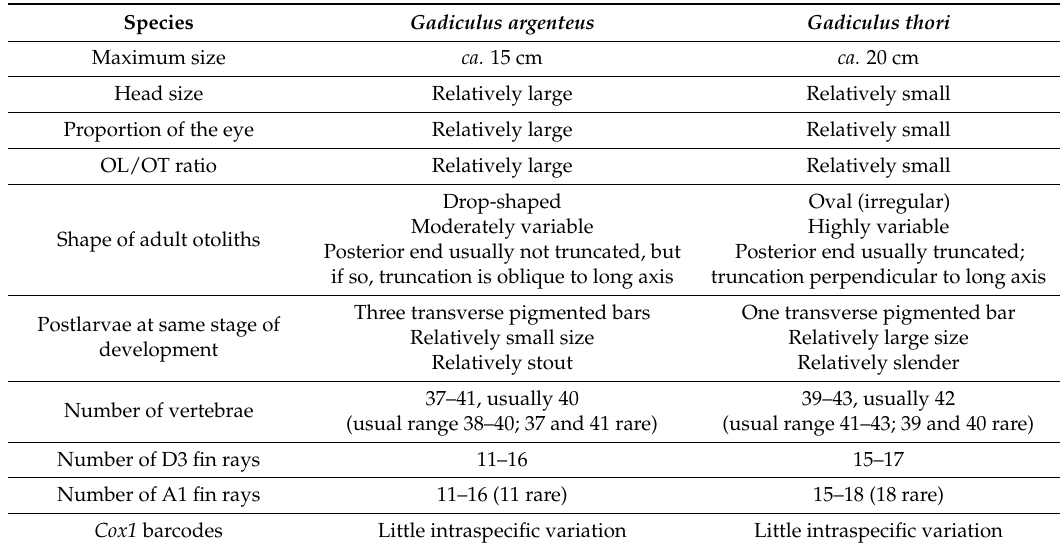
Table 3. Evidence supporting Gadiculus argenteus and G. thori as separate species. Species Gadiculus argenteus Gadiculus thori ca. 15 cm ca. 20